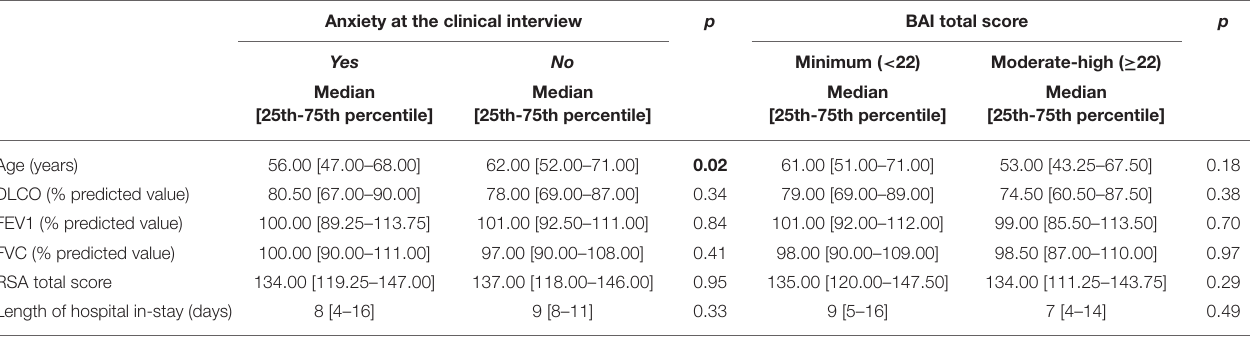
TABLE 2 | Anxiety as assessed at the psychiatric interview and with the BAI: Mann-Whitney test results. Anxiety at the clinical interview